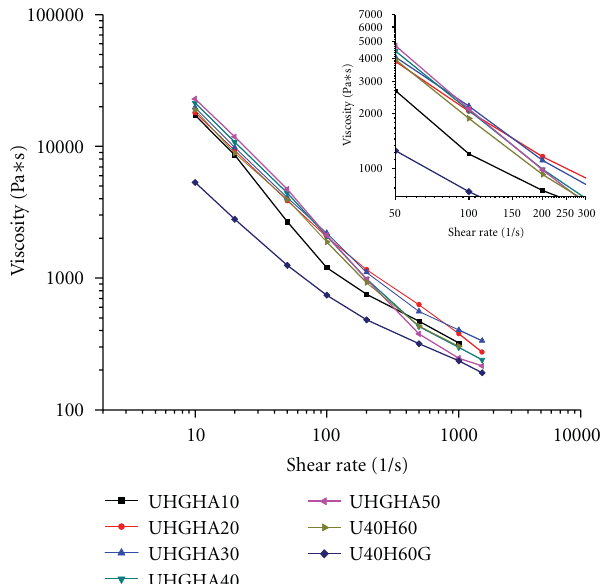
Figure 4: Apparent flow curves of UHMWPE/HDPE, UHMWPE/ HDPE/PEG blends, and UHMWPE/HDPE/PEG/HA composites at temperature of 195 ◦ C. The insert shows the curves at shear rates above of 100 s − 1